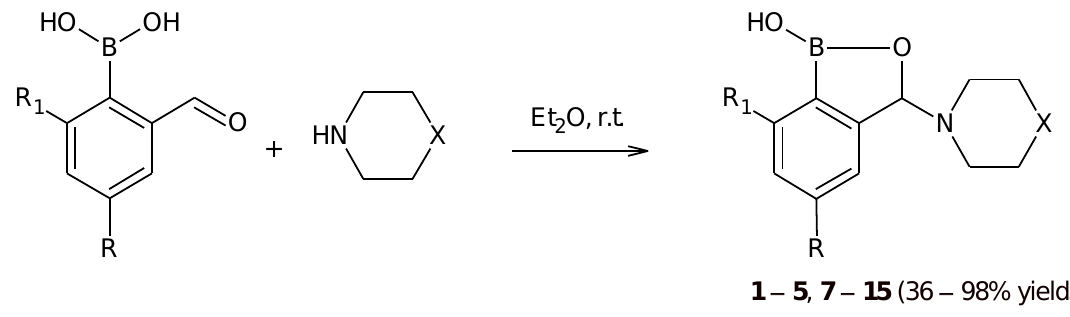
Scheme 1. Synthetic procedure for the studied